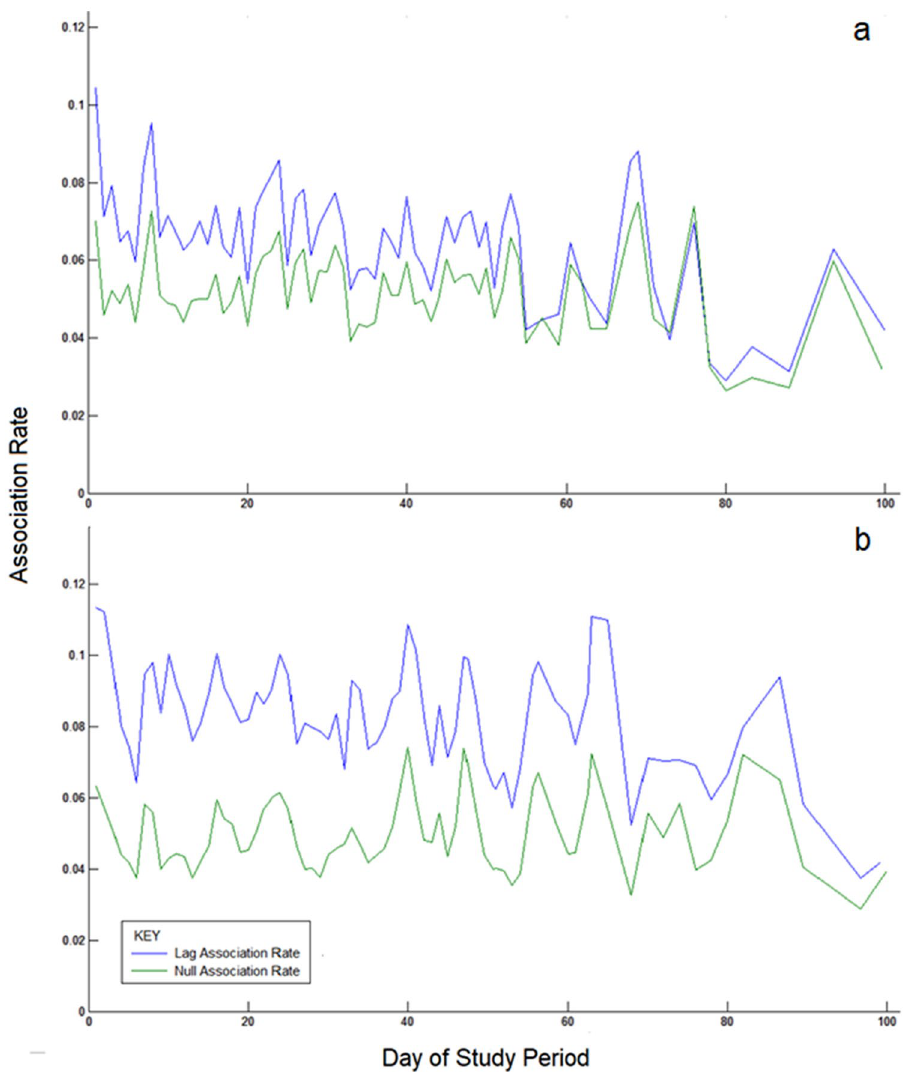
Figure 1. Comparison of the lag (blue) associations rates (the observed probability that two individuals which are associating during a particular sample session (day) will associate again in the future) and the null (green) associate rates (the expected lag association rate if the birds were randomly associating) for the Caribbean ( a ) and Chilean ( b ) flocks. In both cases, the lag association rates were statistically higher than the null associate rates (Caribbean, p = 0.026; Chilean, p < 0.001) suggesting non-random